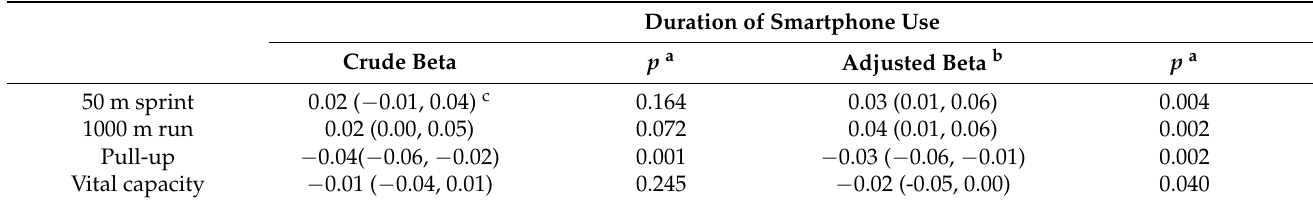
Table 3. Association between duration of smartphone use and physical fitness in 6770 males. Duration of Smartphone